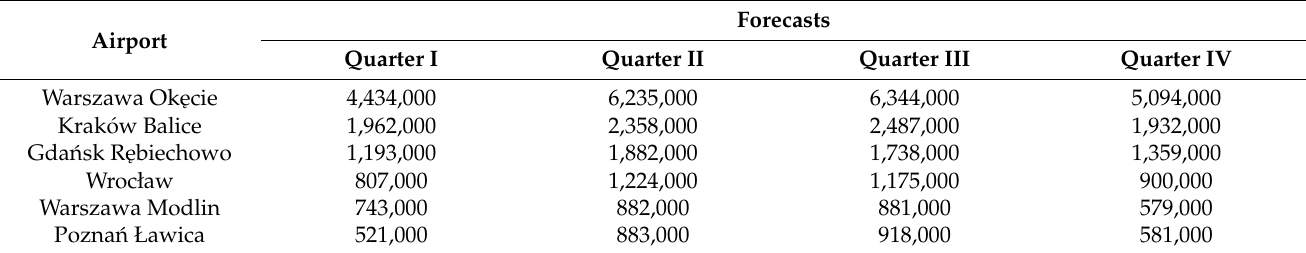
Table 8. Forecasts for individual quarters of the year 2020—the linear trend method with seasonality. Airport